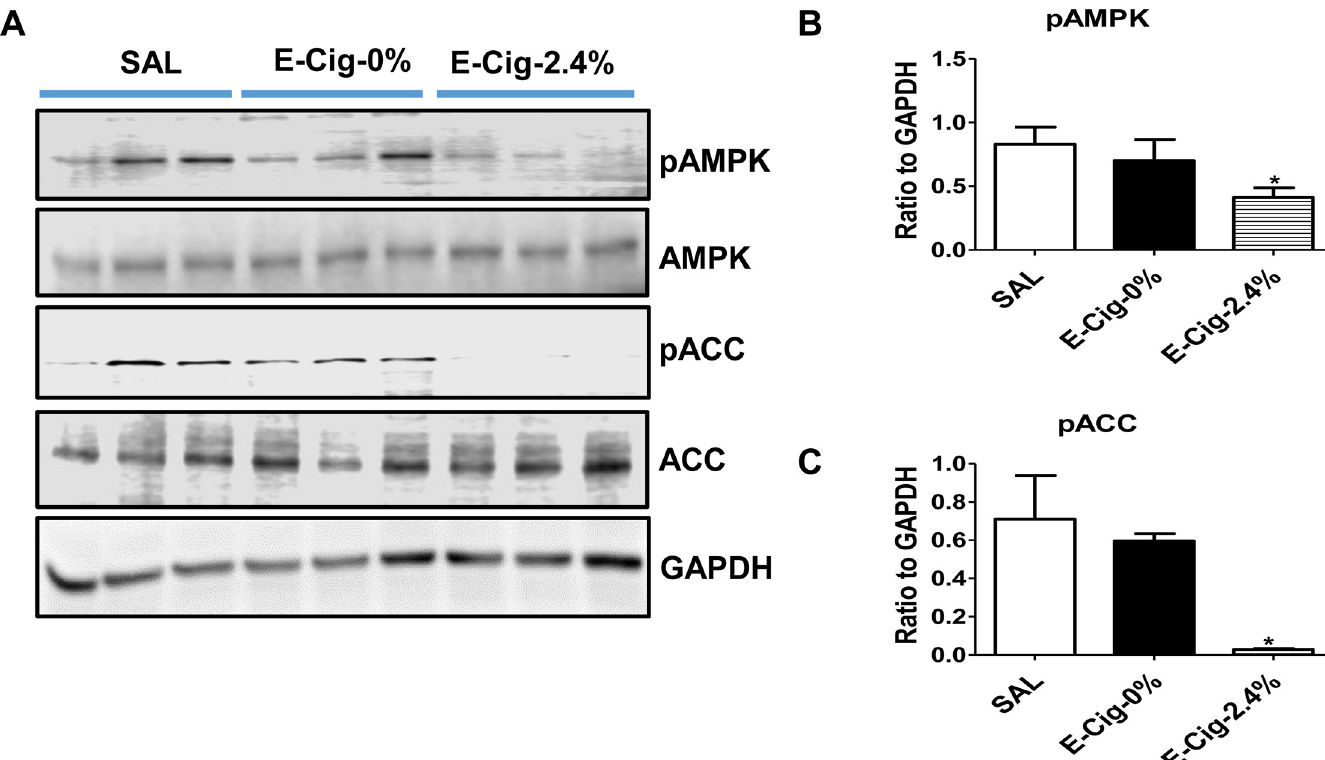
Fig 5. E-cigarettes (2.4% nicotine) plus HFD triggers oxidative stress. Immunohistochemical analysis of ventricular sections show increased expression of 4-HNE in mice exposed to e-cigarette (2.4% nicotine) compared with saline- or e-cigarette (0% nicotine)-treated mice ( A). Western blot analysis shows increased 4-HNE levels in mice exposed to e-cigarette ( B ). ( C ) Quantitation of band intensities. Data for p-AMPK and p-ACC were normalized to GAPDH. P < 0.05. Values are given as means ± SE of 5 mice per group. � P < 0.05.